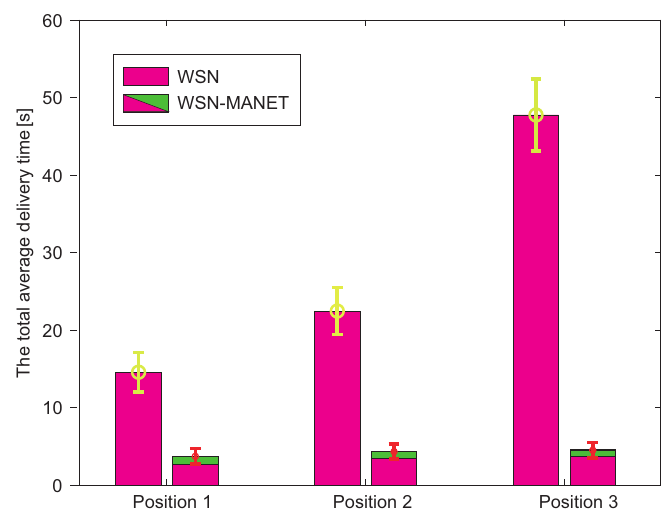
Figure 19. The total average delivery time of 100 Kb urgent data from the source sensor to the AP.